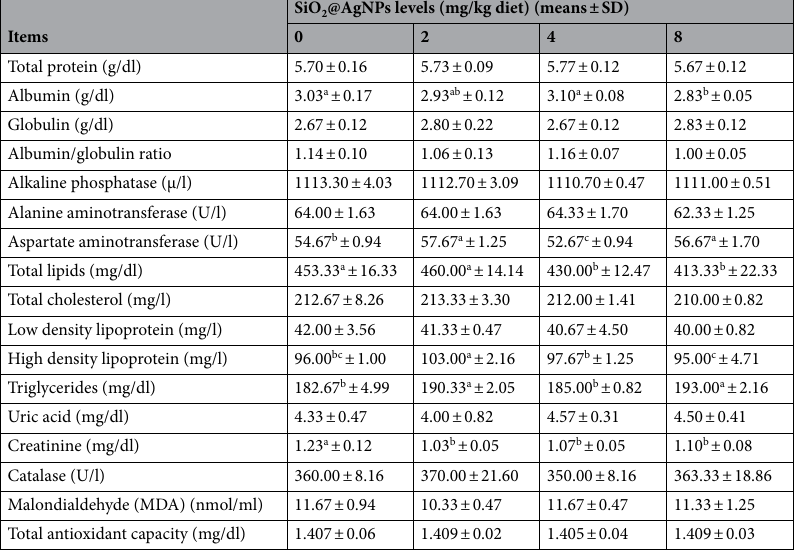
Table 3. Effect of SiO 2 @AgNPs on blood serum constituents of boiler chickens at 5 weeks of age (n/group = 6). Means not bearing superscripts are not statistically differed (P > 0.05). a —c Means in the same row having different letters are significantly different at (P < 0.05).